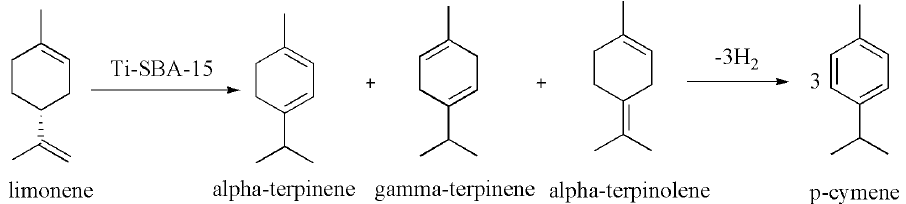
Figure 2. The reactions that proceeded during the process of limonene isomerization.